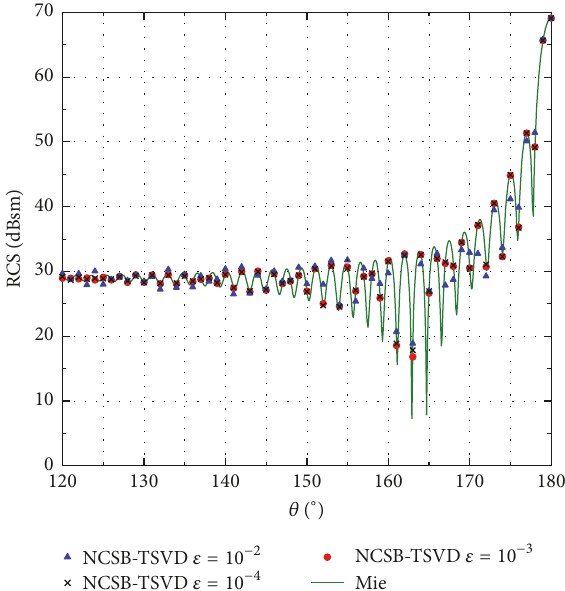
Figure 5: Bistatic RCS of a PEC sphere with a diameter 32𝜆 , by NCSB-TSVD and Mie-series